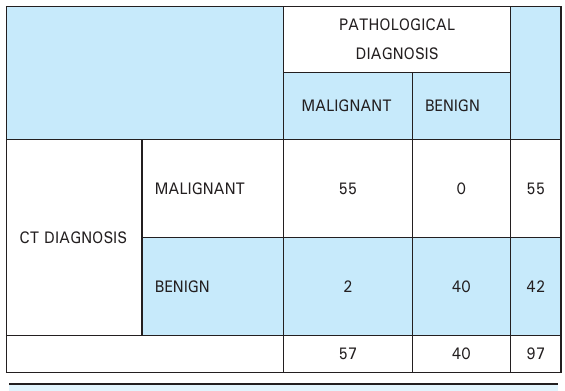
Table 4. CT and Pathological Correlation of Benign Vs Malignant